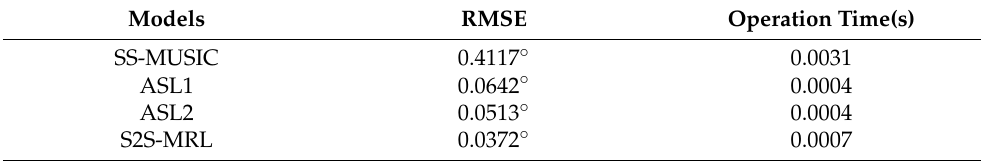
Table 6. The test time of two coherent signal sources is estimated at 5 dB